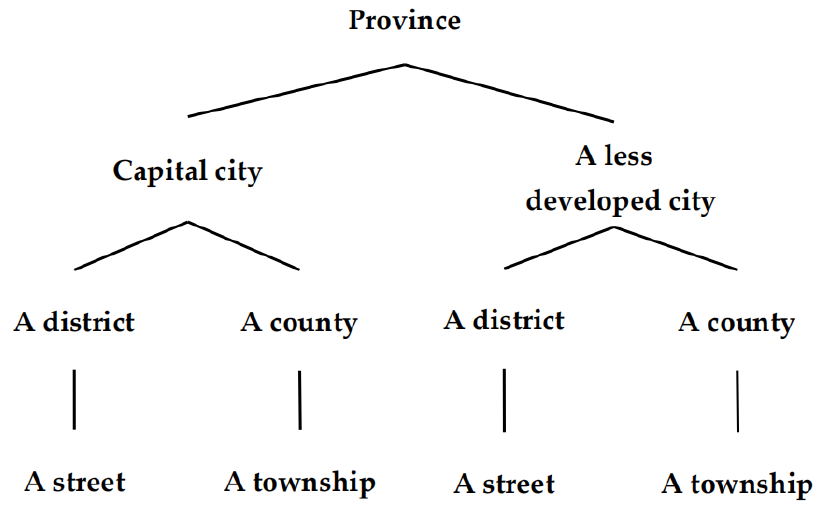
Figure 1. Sampling flow